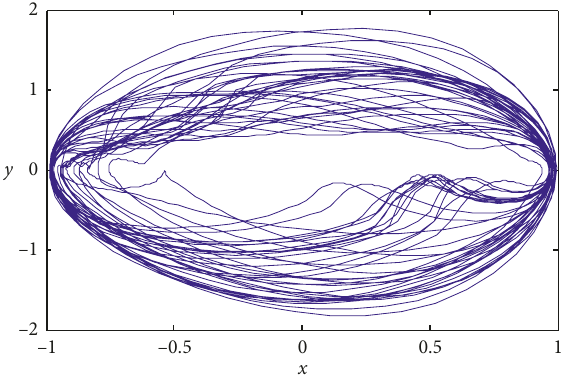
Figure 13: Orbits at the position of pedestal looseness (looseness clearance